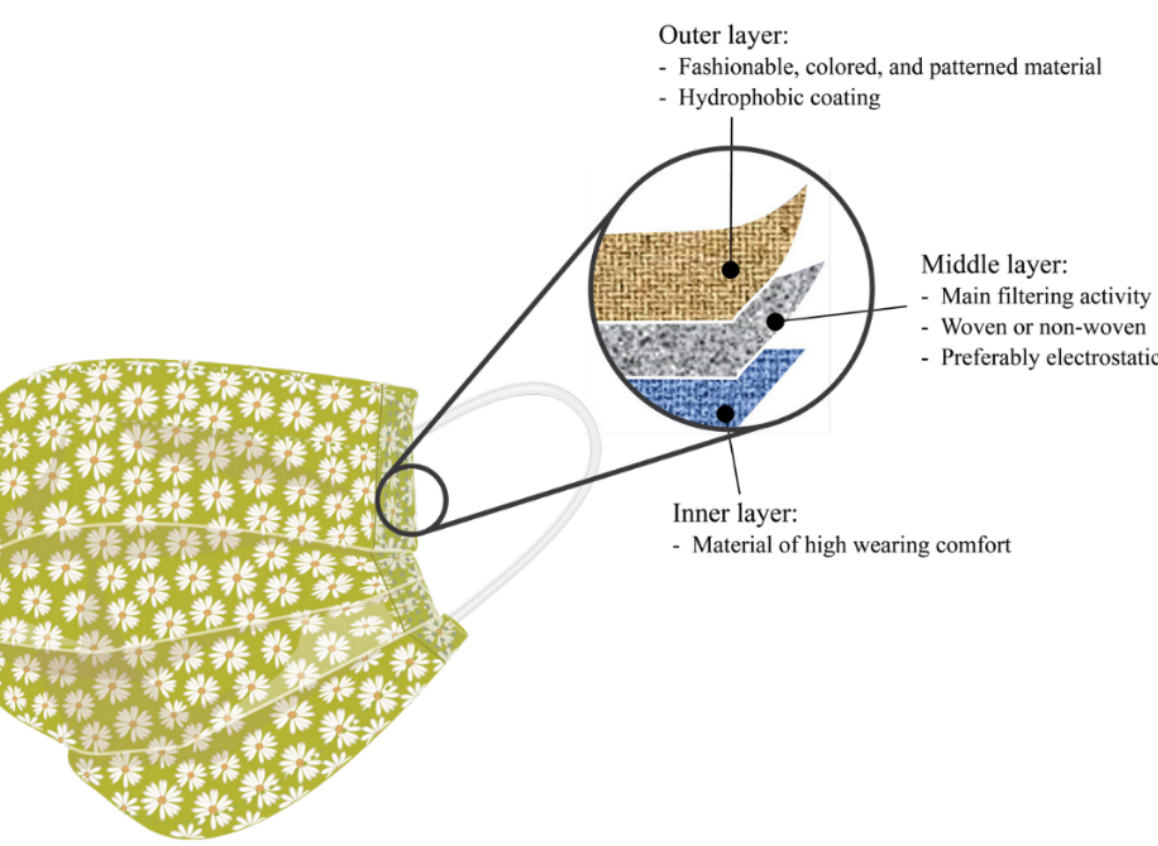
Figure 6. Four-layer N95 respirator mask [69].